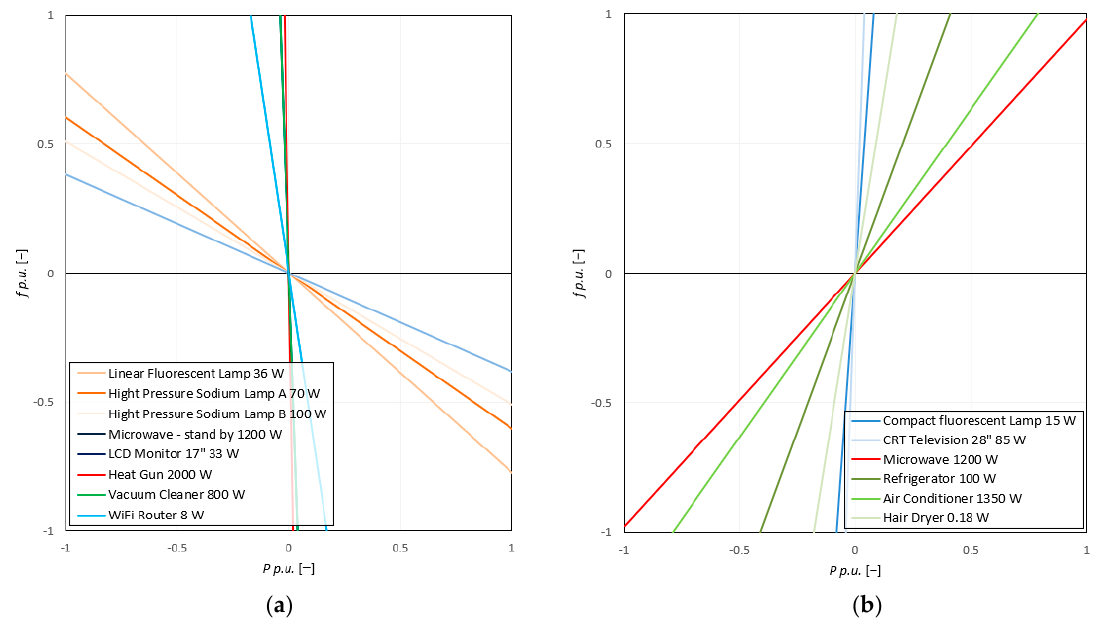
Figure 7. Graphical comparison of analyzed single-phase appliances according to the value of frequency sensitivity coefficient ( a ) negative: K P < − 0.01; ( b ) positive: K P > 0.01. Table 6. Comparison of light